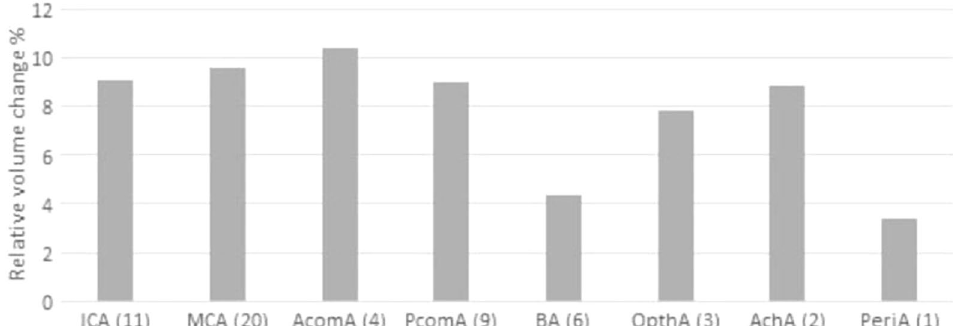
Figure 5. Mean relative voume change per aneurysm location. Error bars indicate the standard deviation. ICA = Internal Carotid Artery, MCA = Middel Cerebral Artery, AcomA = Anterior communicating Artery, PcomA = Posterior communicating Artery, BA = Basilar Artery, OpthA = Opthalamic Artery, AchA = Anterior choroid Artery, PeriA = Pericallosal